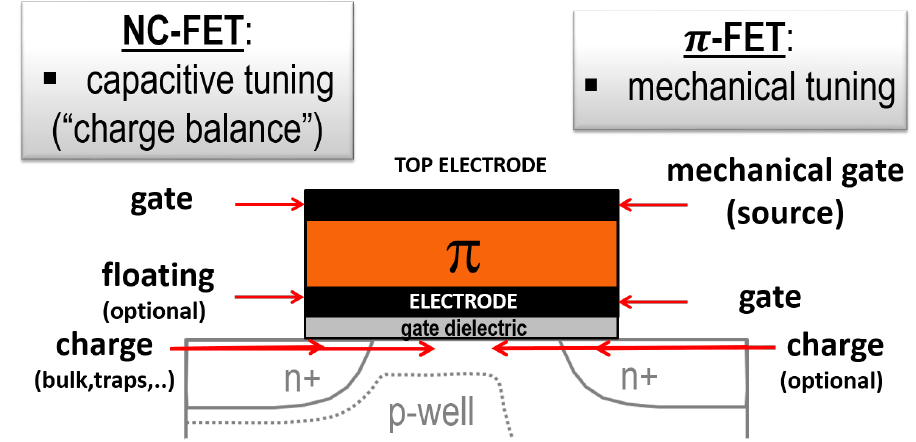
Figure 1. Schematic cross-section of a bulk NC-FET (left) and π -FET. Both device concepts comprise a ferroelectric material for obtaining a positive feedback in the gate control of the current in a conventional MOSFET. In case of the NC-FET, the top electrode represents the gate, and there is an optional floating electrode for technological reasons and to smear out potential fluctuations in the